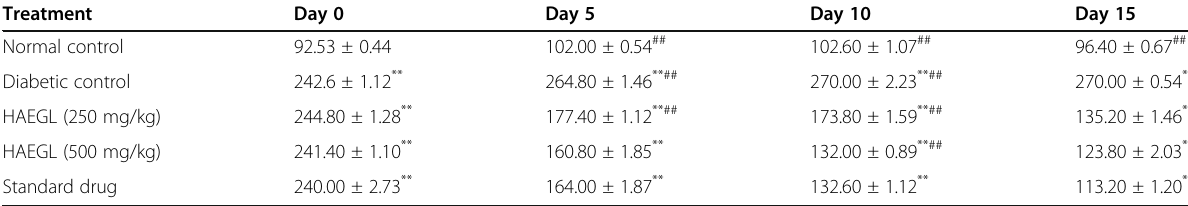
Table 5 The effect of HAEGL on fasting blood glucose level on streptozotocin-induced diabetic rats during 15 days of treatment Treatment